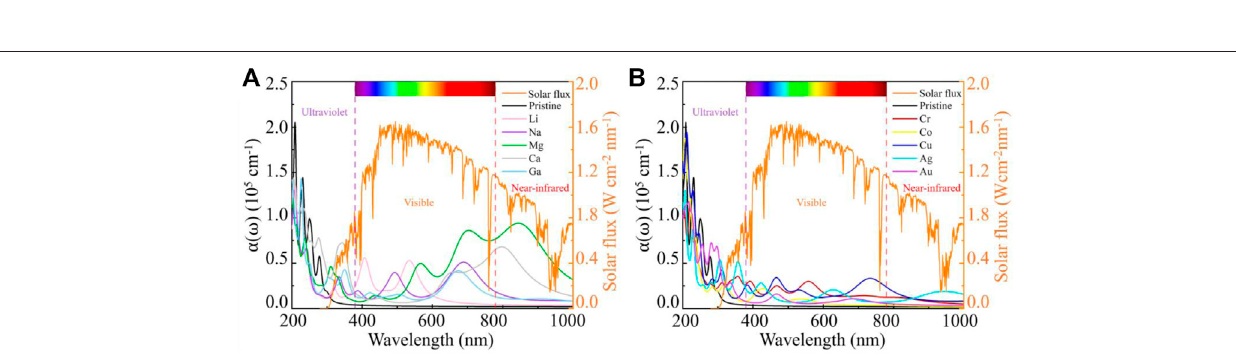
Frontiers in Chemistry |